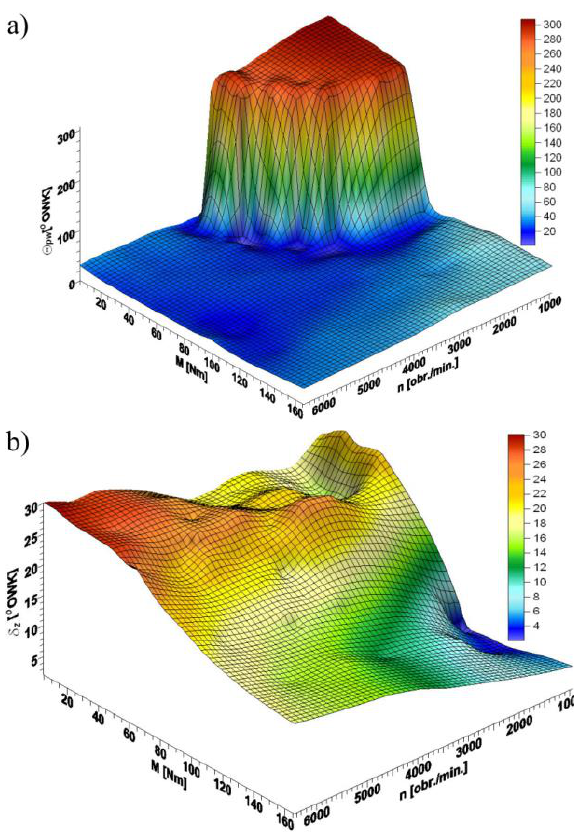
Fig. 3. Maps of: injection start angle (a) and ignition advance angle (b) for Mitsubishi Carisma GDI engine [8]